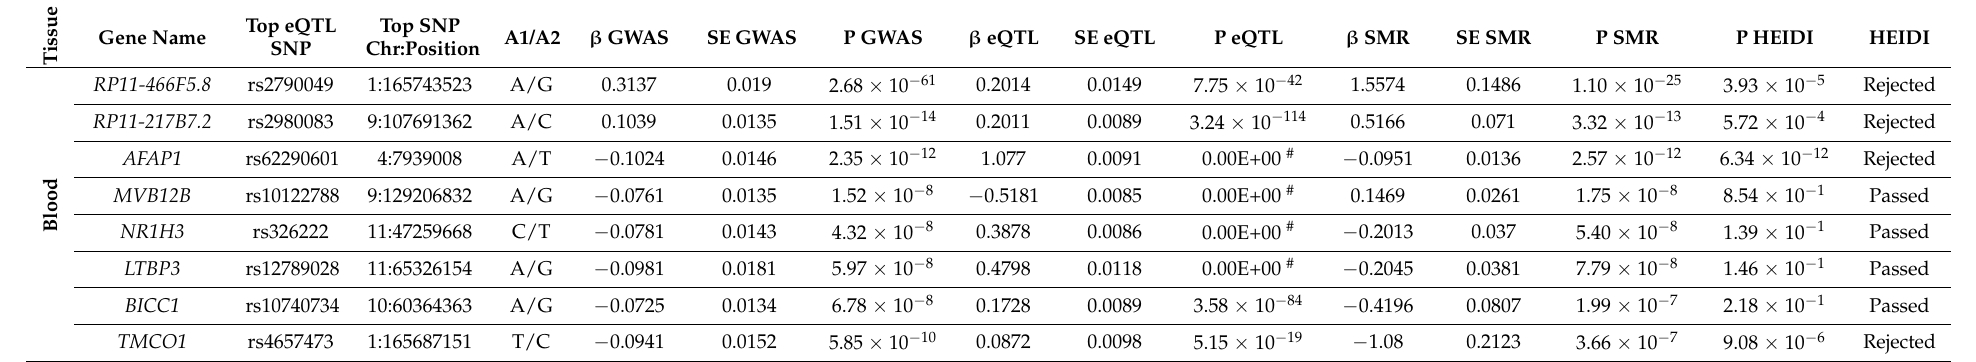
Table 4. Significant SMR results of POAG GWAS using eQTLGen dataset (https://www.eqtlgen.org/, accessed on 10 December 2019) of whole blood and